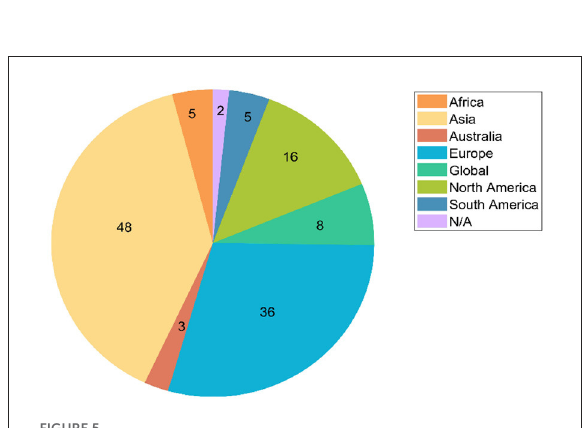
FIGURE5 Country location of case studies for the reviewed works.